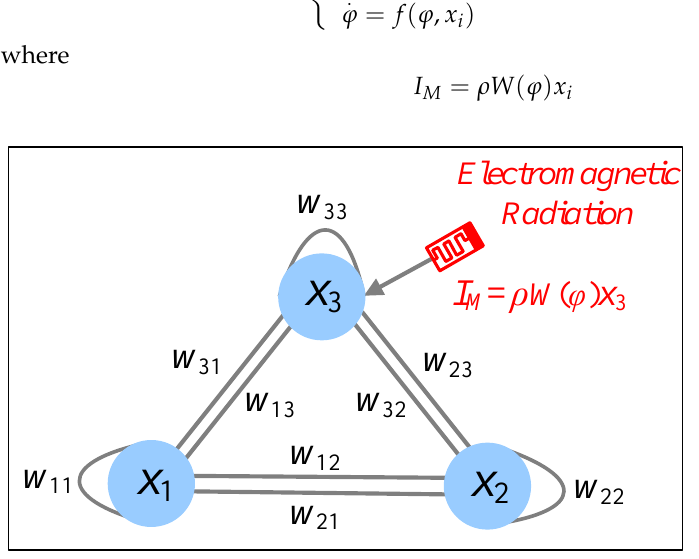
Figure 3. Connection topology of an MHNN under external electromagnetic radiation.